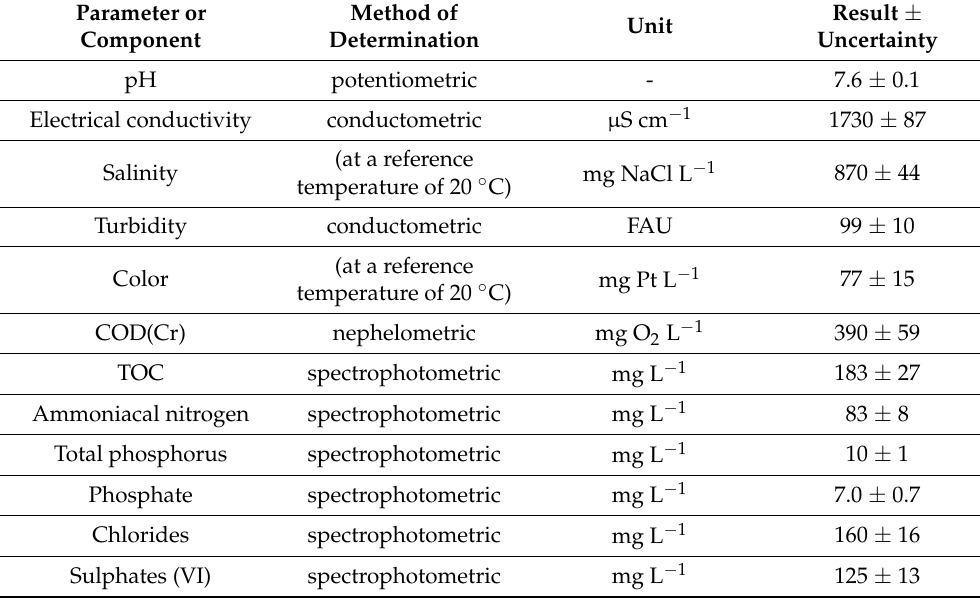
Table 7. Characteristics of wastewater used in adsorption